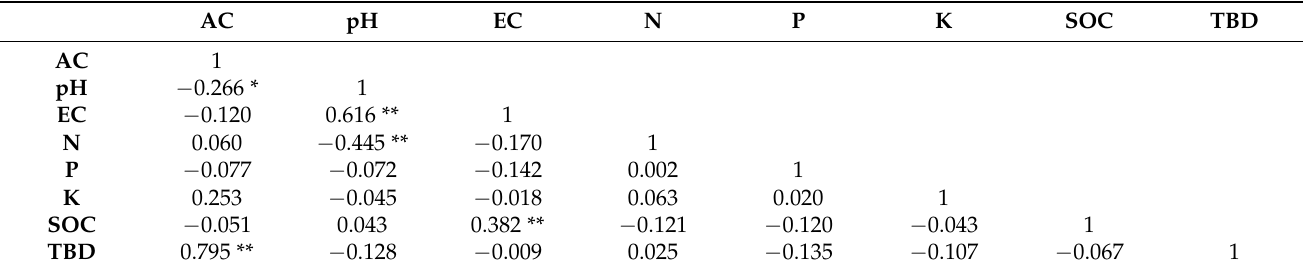
Table 3. Pearson correlation matrix of stand, soil properties Total Biomass Density (TBD) and